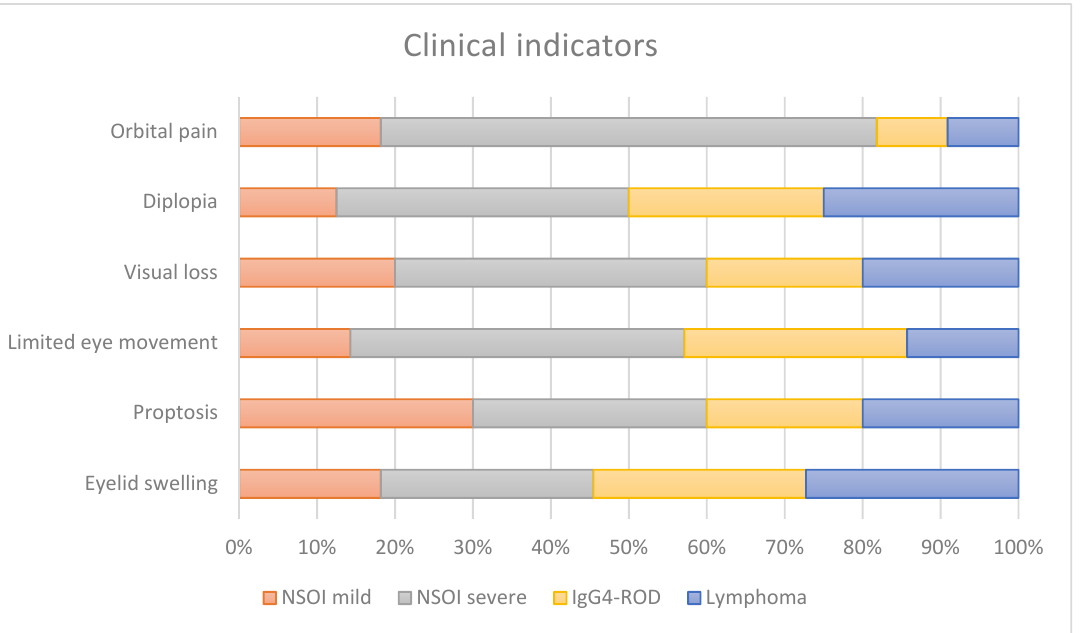
Figure 1. Clinical symptoms present in our index population stratified for each disease entity and subtype of disease.